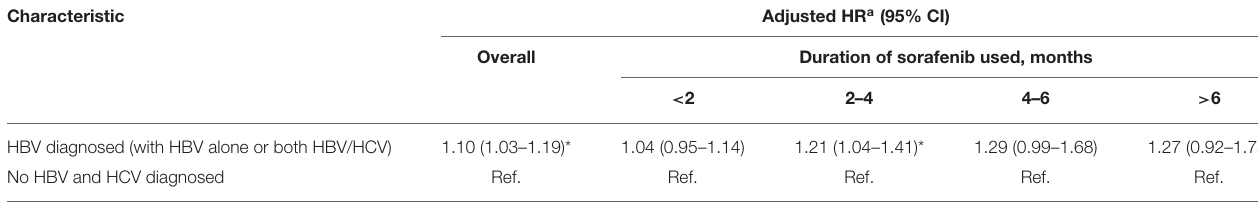
TABLE 2 | Risk of 1-year mortality in HCC patients receiving sorafenib with or without HBV/HCV.